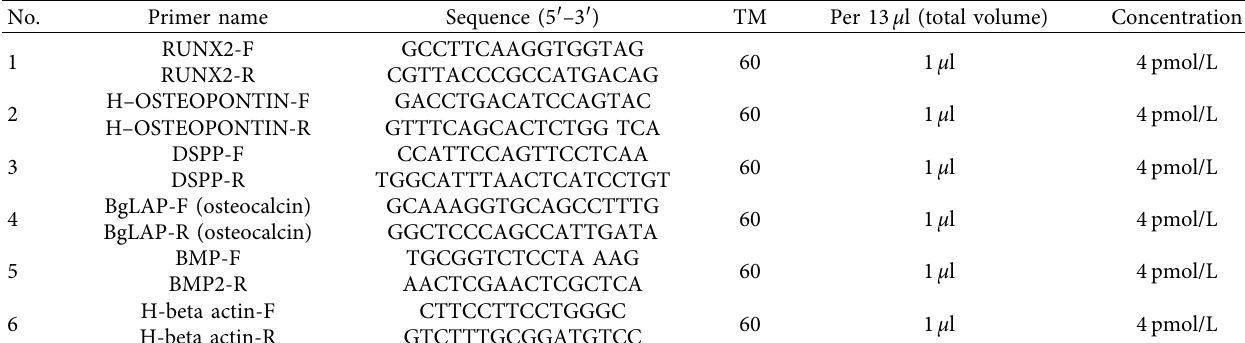
Table 2: Te primer sequences used in the current study.